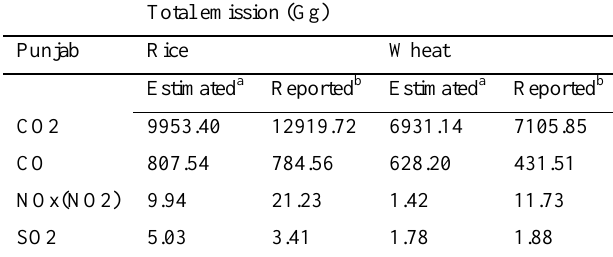
Table 8. Comparison of the estimated total emission of GHGs to reported total emissions in Punjab (2008-09). a Estimation for the year 2008 (during rice straw burning) and 2009 (during wheat straw burning). b Estimates of 2008-09 (Jain et al., 2014)